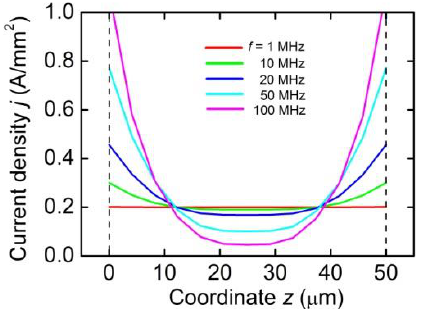
Figure 7. Current density distribution over the thickness of the Cu electrode for different current frequencies f from 1 MHz to 100 MHz.